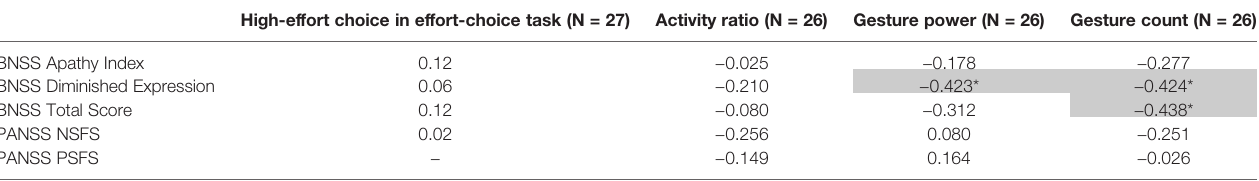
TABLE 2 | Spearman ’ s correlation between high-effort choice, activity, and gesture features with clinical scores. High-effort choice in effort-choice task (N = 27) Activity ratio (N = 26) Gesture power (N = 26) Gesture count (N = 26)